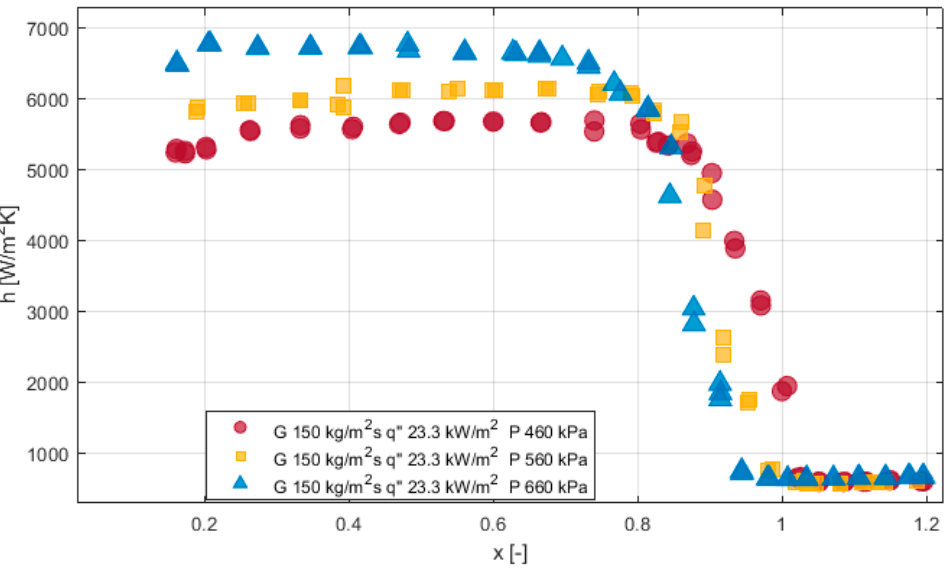
Figure 6. Effect of saturation pressure on heat transfer coefficient for mass flux of 150 kg/m 2 s and heat flux of 23.3 kW/m 2.